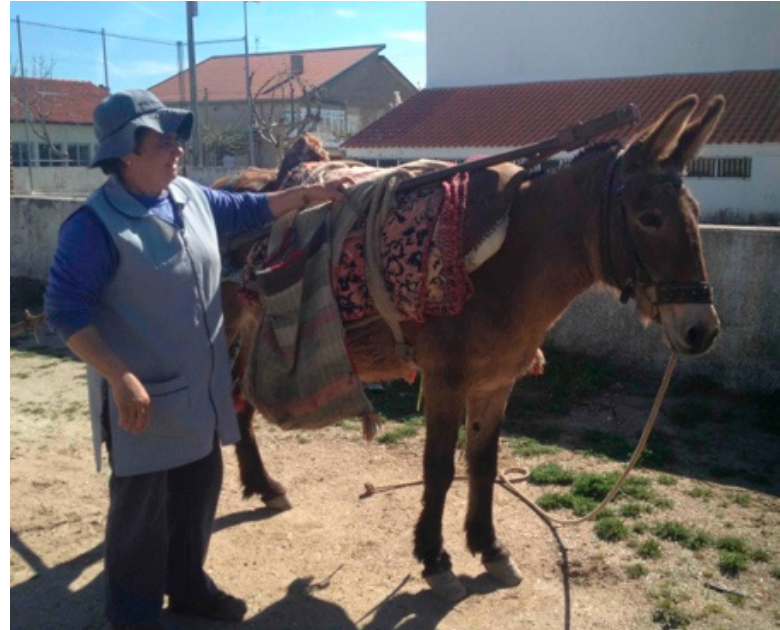
Figure 4. Hinnies are commonly found in many countries where access to mares has been traditionally limited. This particular hinny is used to plow and dig up potatoes and assist with harvesting grapes in Portugal. In some places they are preferred over